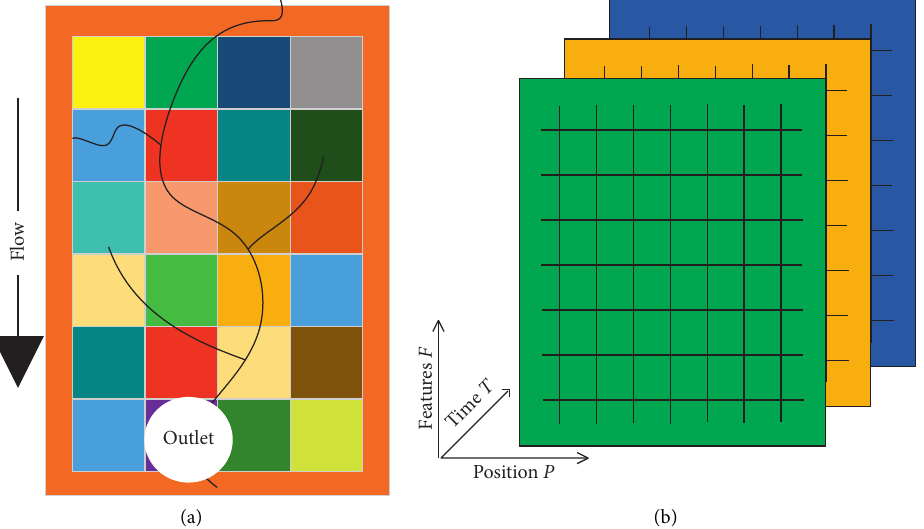
Figure 5: Illustration of the reconstructed data structure for information acquired from ECWMF: (a) abstract Lech river basin with large spatial grids and (b) data representation for input hydrological factors with three independent dimensions to represent feature, position, and time,